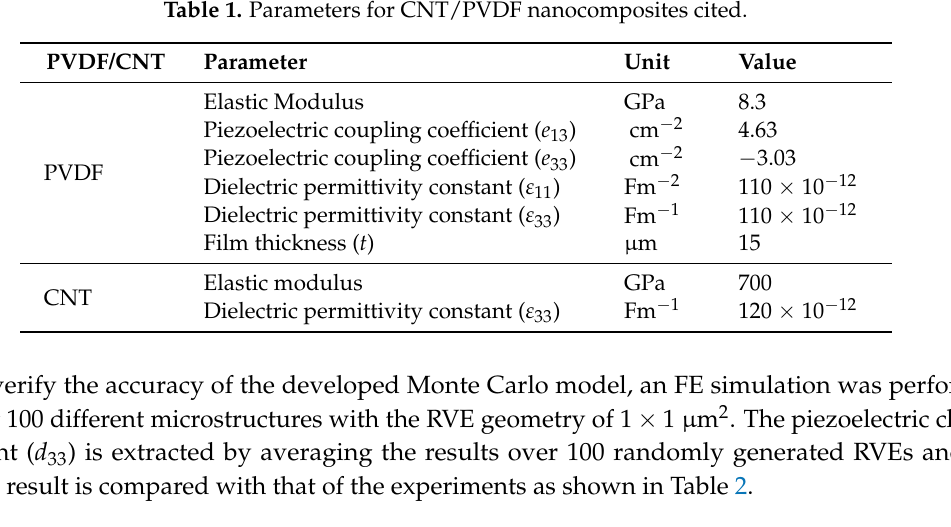
Table 2. Piezoelectric charge constant results.